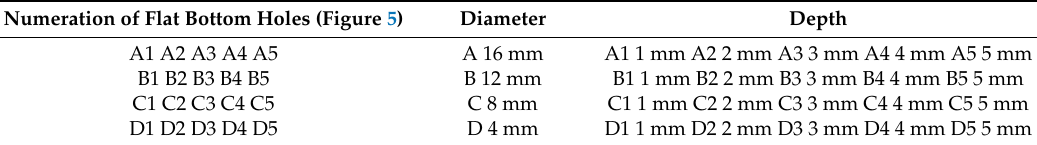
Table 1. Flat-bottom holes sizes and depths of the tested sample.